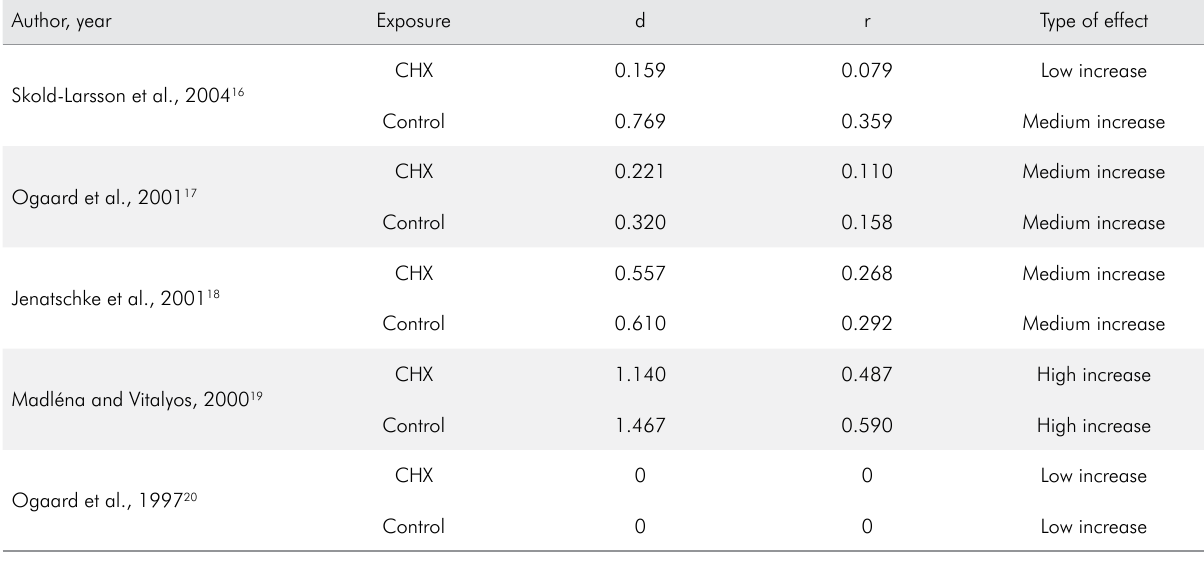
Table 3. Effect size of the included